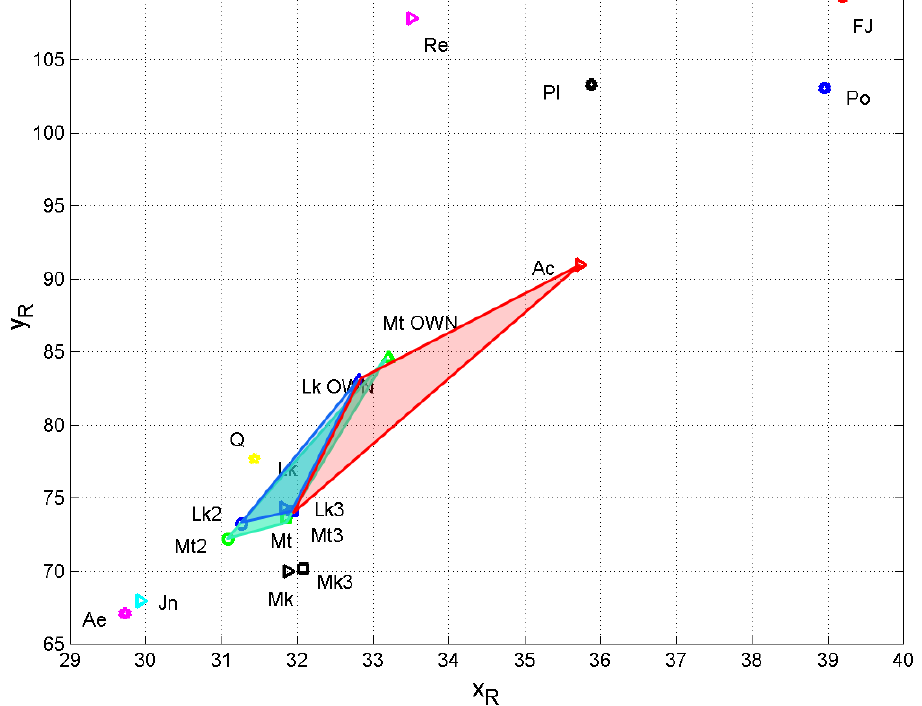
Figure 19. Coordinates x R and y R of the resulting vector (1) of the texts considered. Same symbols as Figure 18. The green triangle refers to Matthew; the blue triangle refers to Luke. The red triangle extends Luke’s literary area (blue + red) to the Acts.